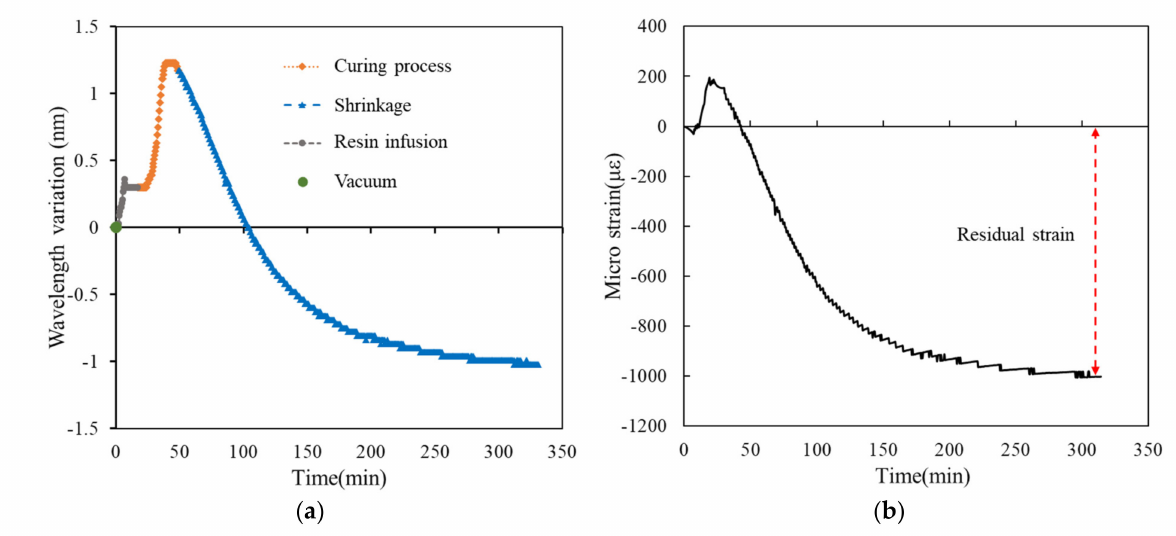
Figure 13. Experimental results of surface laminate—stacking number is 40. ( a ) Wavelength-variation varying with time. ( b ) Residual